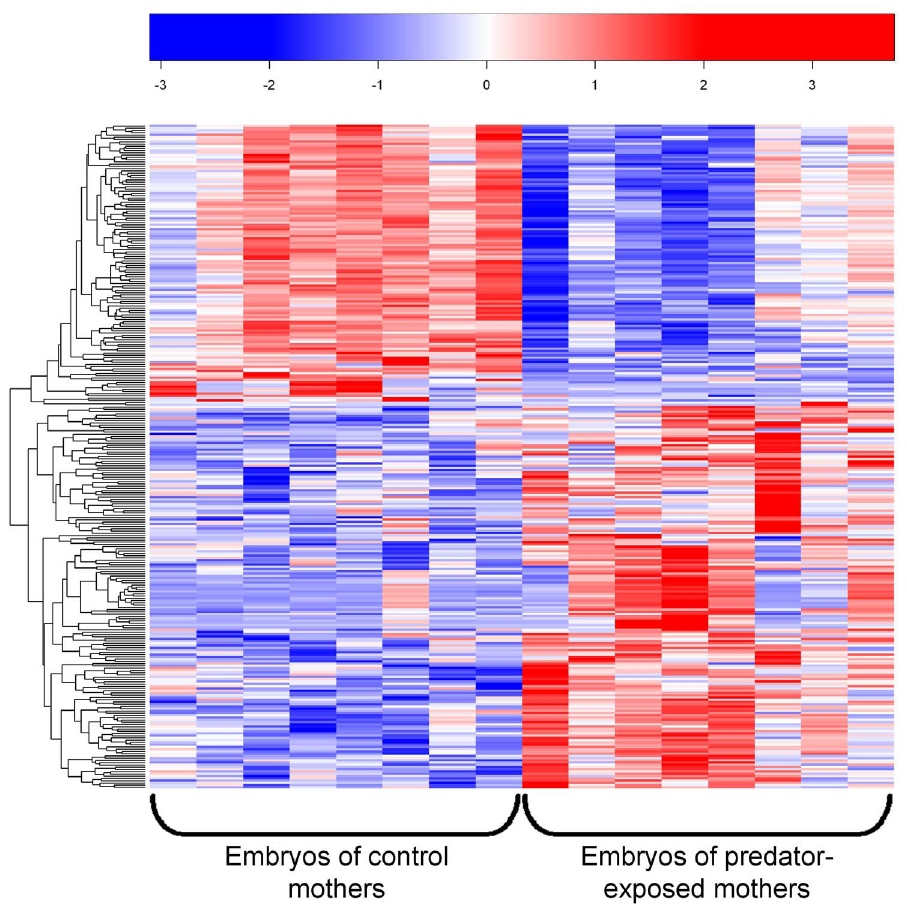
Figure 1. Exposing mothers to a predator led to an overall activation of genes in stickleback embryos. The heatmap shows the general pattern of gene regulation for the 295 genes differentially expressed (EdgeR) as a result of maternal exposure to predation risk. Red = upregulated, blue = downregulated compared to the mean value of a gene from all samples. Rows represent genes and columns represent clutches (one clutch per mother, n=16 mothers total). log(CPM) data are normalized for library size and scaled so that every gene has the same mean (0) and standard deviation; units of change are standard deviations from the mean, and each row has the same range of color values.